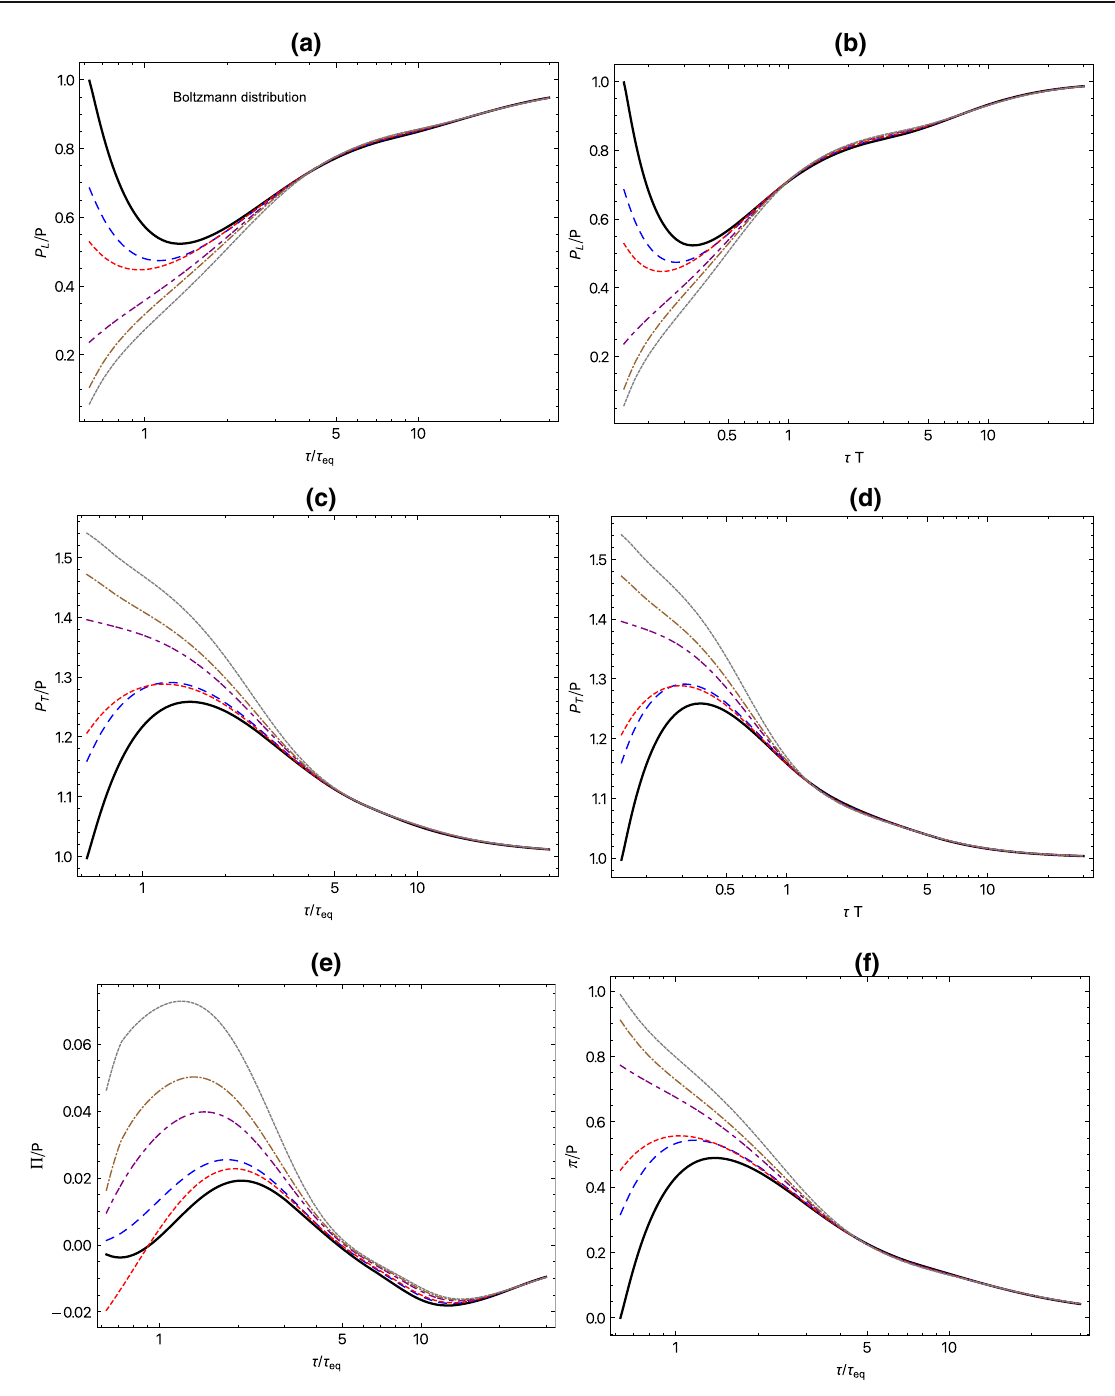
Fig. 3 Top row: evolution of P L / P eq as a function of τ/τ eq and τ T , in the left and right panels, respectively. Middle row: Evolution of P T / P eq as a function of τ/τ eq and τ T , in the left and right panels, respectively.